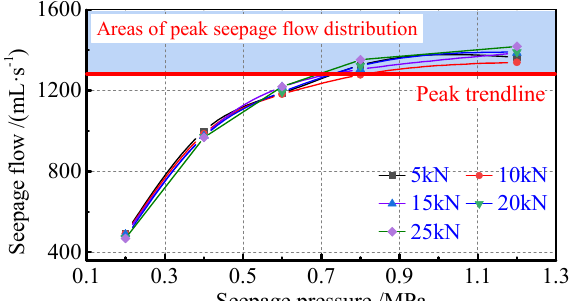
rate enters the peak area, the gas flow rate increases rapidly. The intersection of the peak line and the gas flow rate variation curve is between 0.4 and 0.6 Mpa. The effect of seepage pressure on the gas flow rate of the coal crushing media seepage system is illustrated in Figure 9.